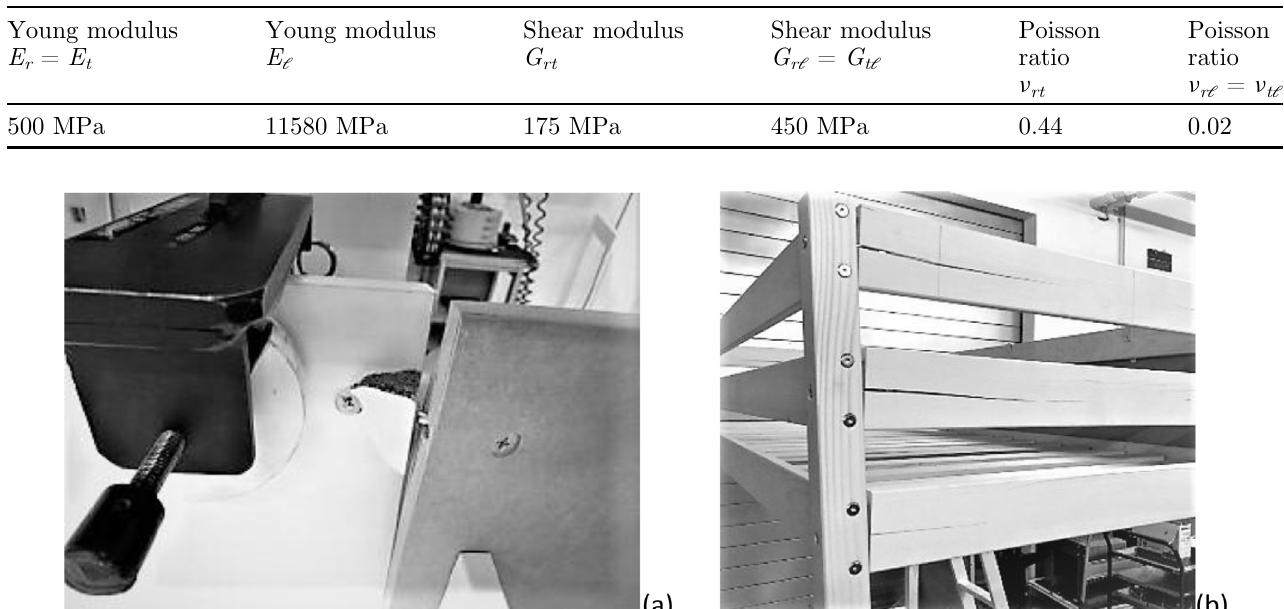
Fig. 1. Two main fracture modes for loft beds: (a) a transverse tearing fracture and (b) a typical cracking-induced